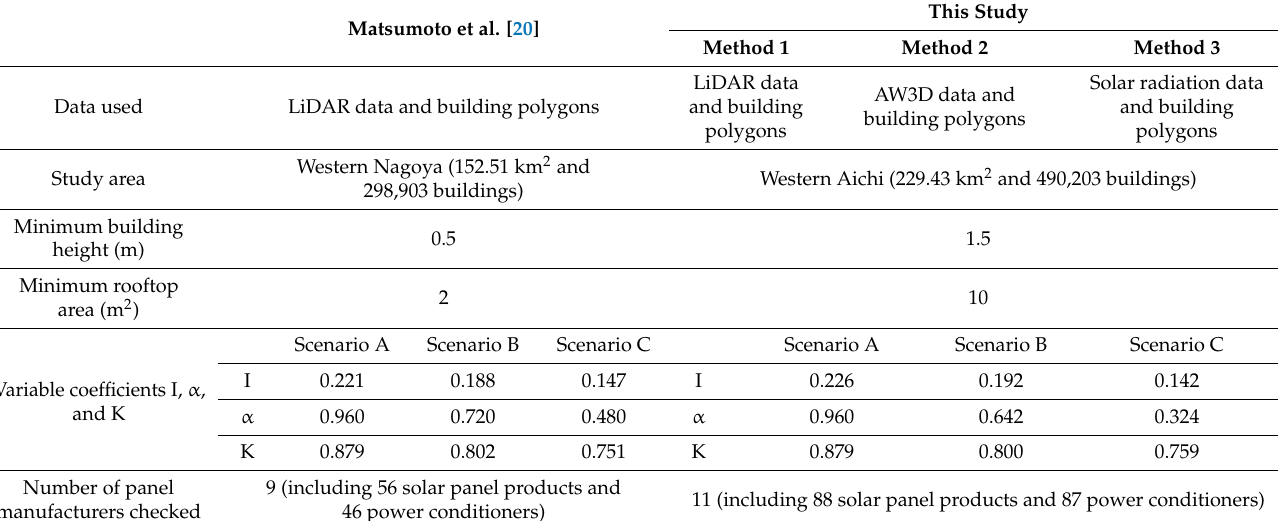
Table 7. Comparison of parameter settings of this study and those used by Matsumoto et al. [20]. This Study Matsumoto et al. [20] Method 1 Method 2 Method